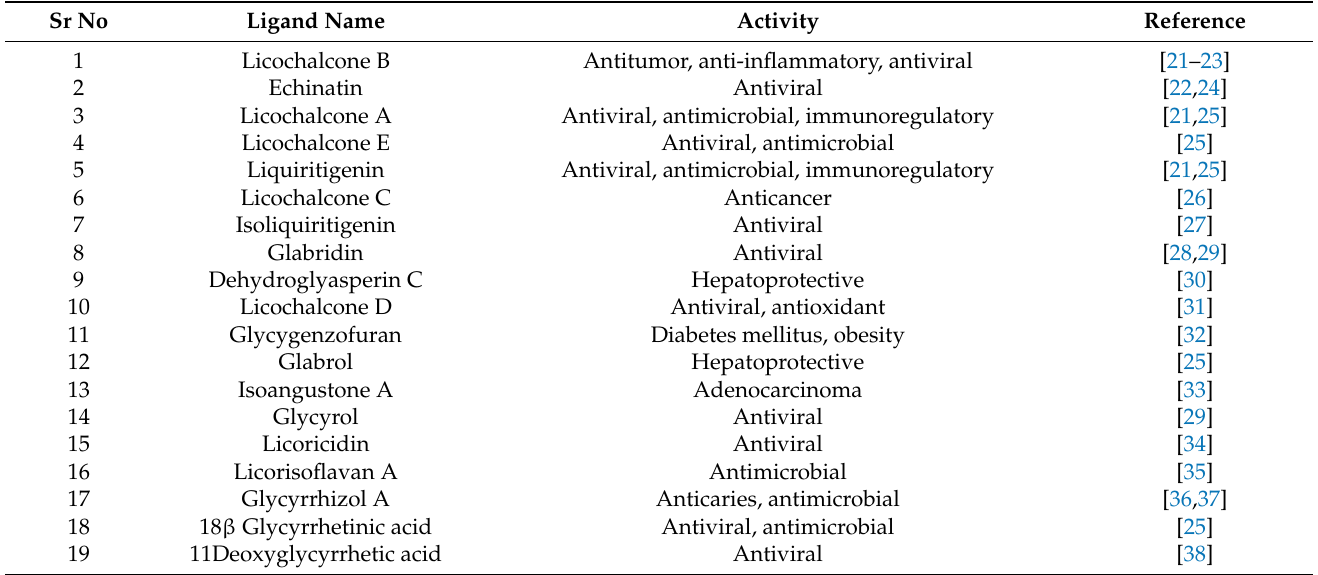
Table 2. Docking energy table of the screened flavonoids calculated by CDocker.